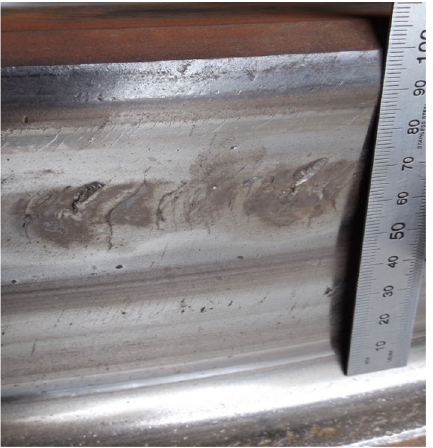
Fig. 3 Martensite and spalling around wheel